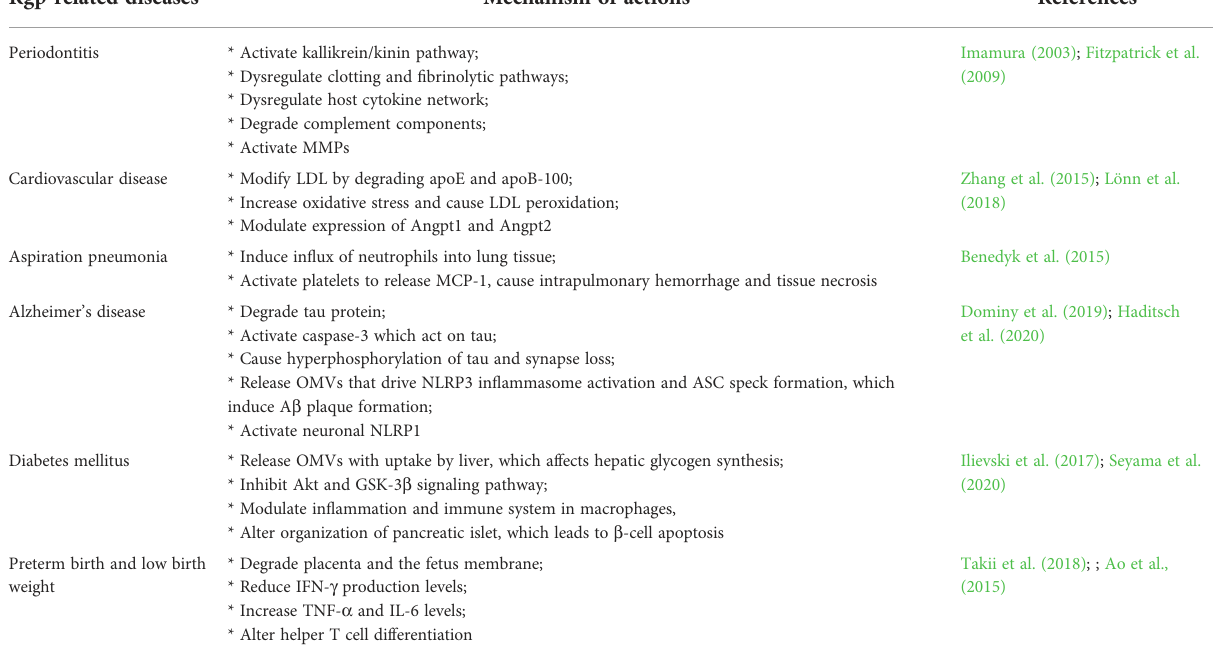
TABLE 2 Rgp-related diseases and its mechanism of